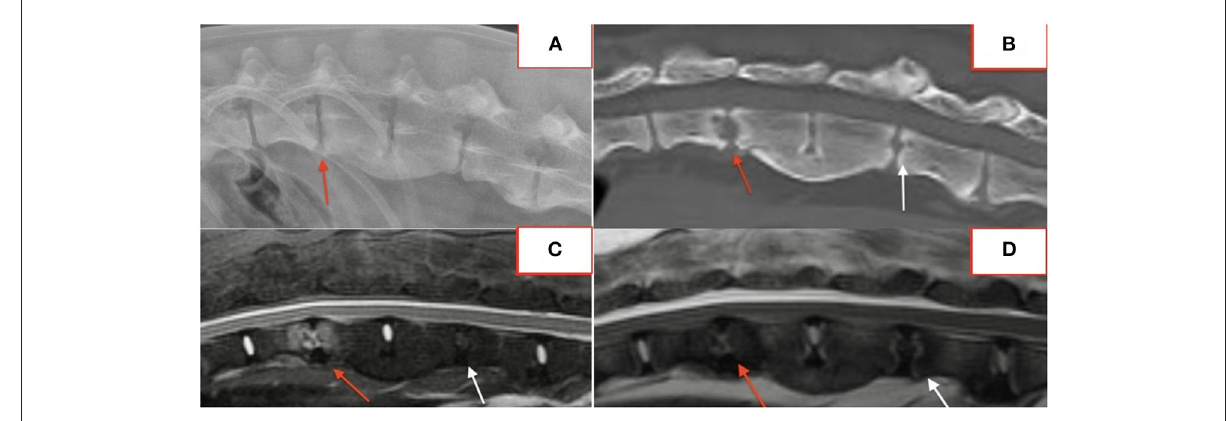
FIGURE5 Lateral radiograph (A) , CT (B) , STIR sagittal MRI (C) , T2 sagittal MRI (D) demonstrating lesions at T13-L1 and